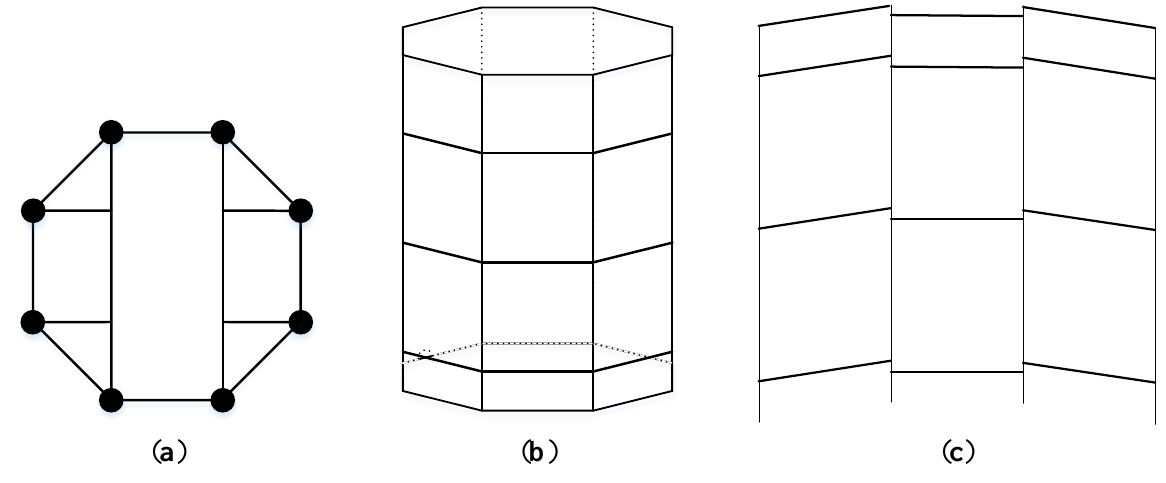
Figure 3. ( a ) Camera locations; ( b ) Frame